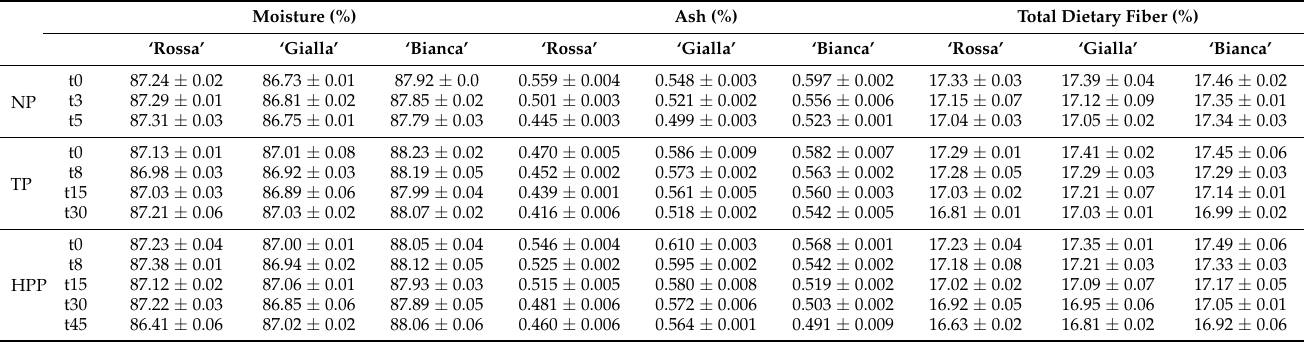
Table 1. Variation in nutritional parameters (moisture, ash and total dietary fiber (%)) of three juices of prickly pear—cv ‘Rossa’ (red juice), cv ‘Gialla’ (orange juice), and cv ‘Bianca’ (white juice) over storage time for non-pasteurized (NP) samples and the two processing methods—high-pressure processing (HPP) and thermal pasteurization (TP). Results are expressed as averages ± SD. Moisture (%) Ash (%) Total Dietary Fiber